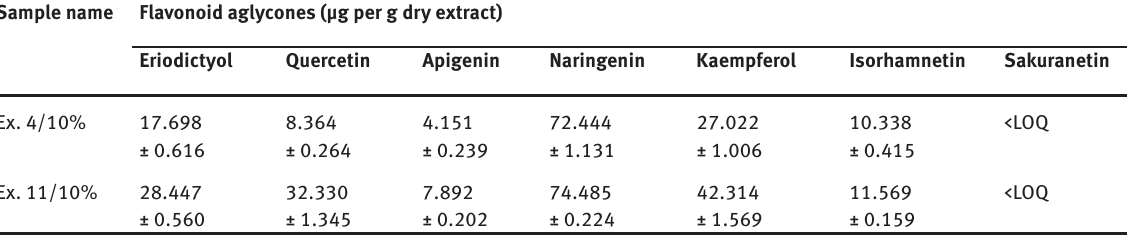
Table 7: Flavonoid aglycones content for extracts with higher amount of tiliroside (Ex. 11/10%) and flavonoids (Ex. 4/10%) obtained from Tilia L. Values are presented in mean ± SD,